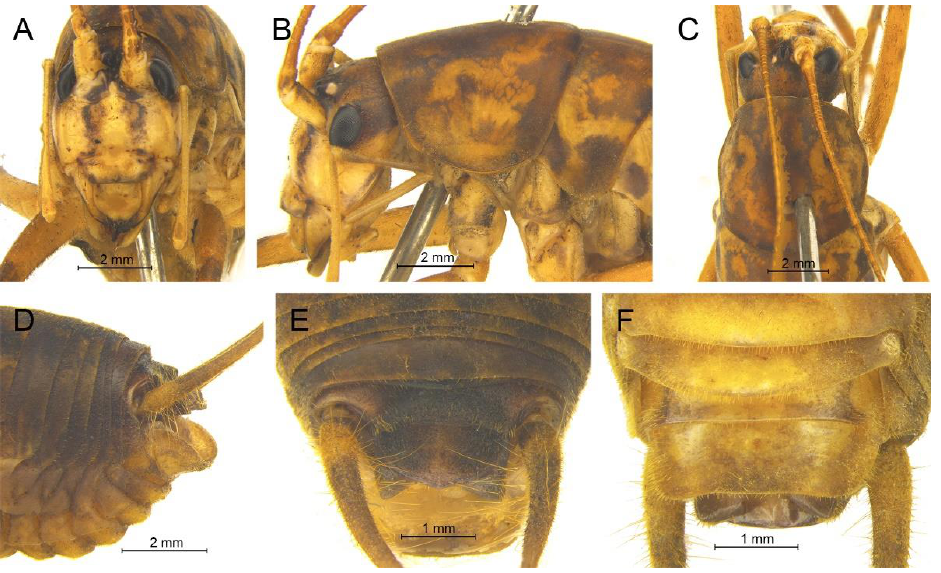
Figure 23. Homotachycines baokangensis Zhu & Shi sp. nov., male: ( A – C ) head and pronotum: ( A ) frontal view, ( B ) lateral view, ( C ) dorsal view; ( D – F ) apex of abdomen: ( D ) lateral view, ( E ) dorsal view, ( F ) ventral view.